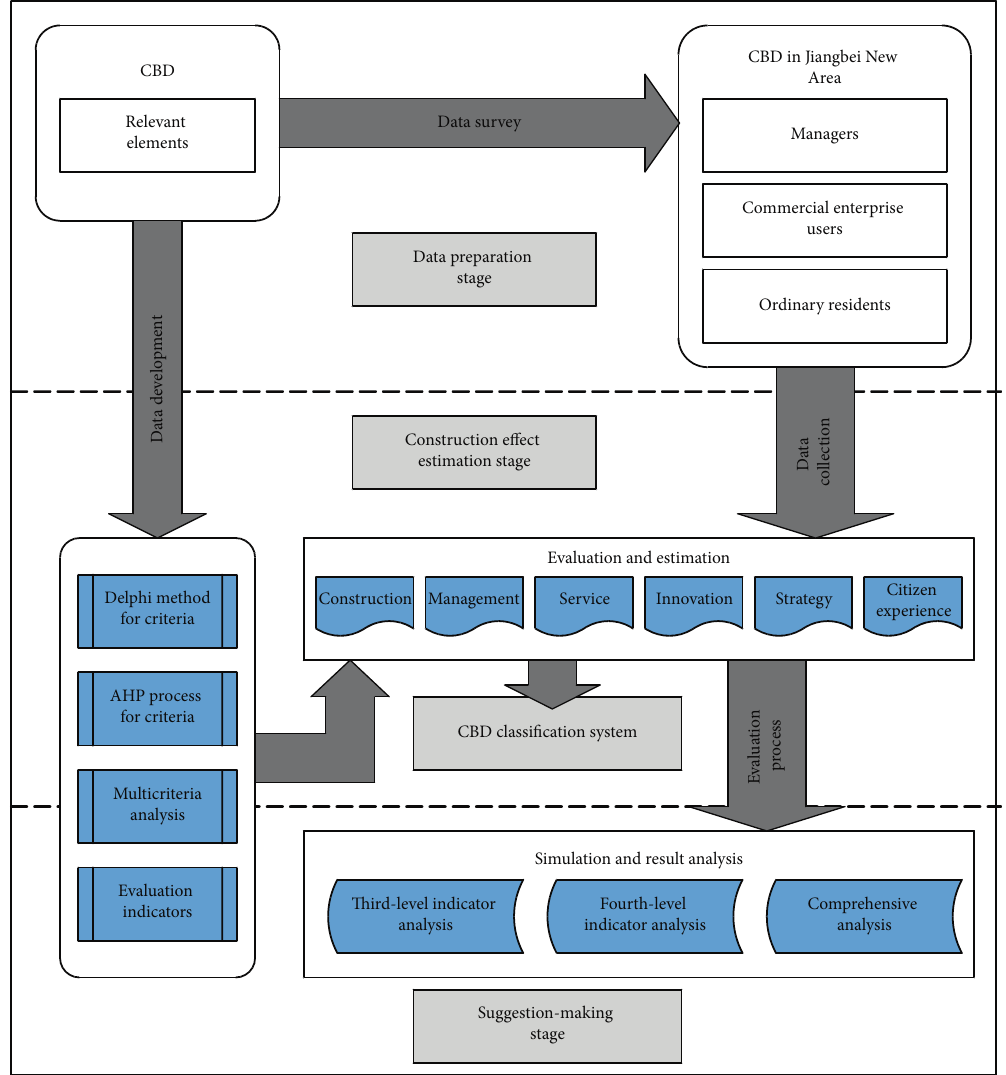
Figure 1: The procedure of the construction effect evaluation of the smart